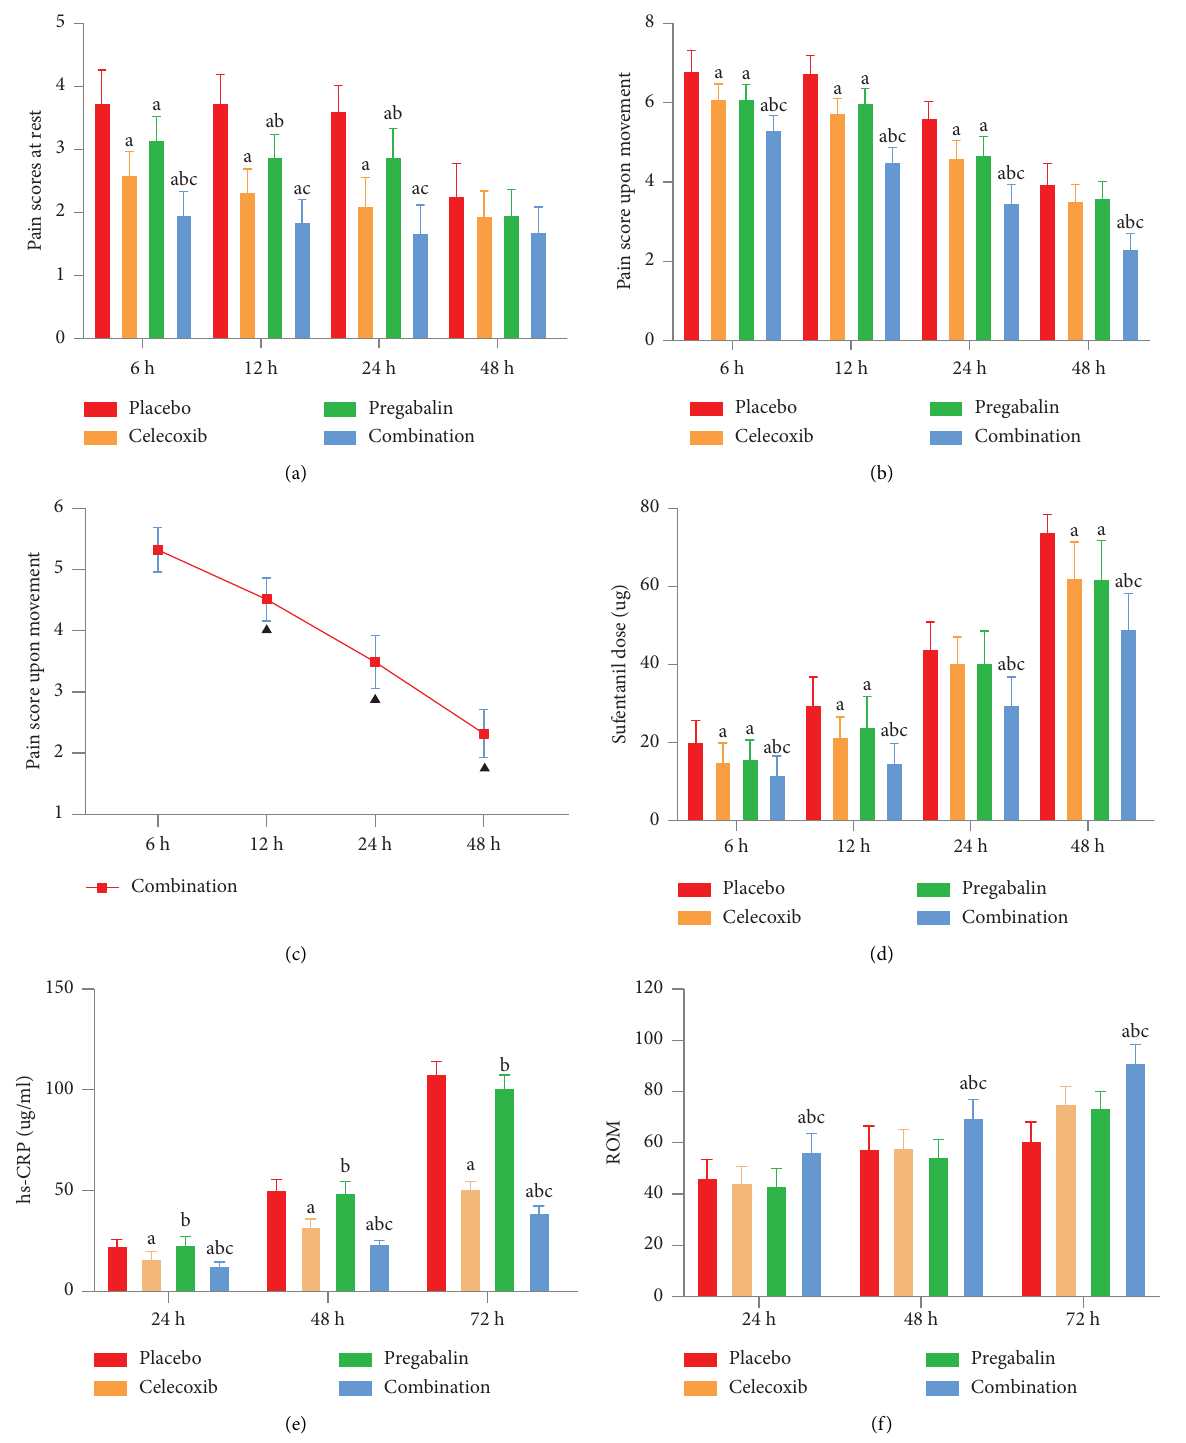
Figure 2: (a) Pain score at rest. (b) Pain score upon movement. (c) Pain score upon movement in the combination group. (d) Cumulative dose of sufentanil. (e) High-sensitivity C-reactive protein (hs-CRP). (f) Knee range of motion (ROM). ▲ indicates a signifcant diference compared with a previous time point in the combination group, which suggests that the pain scores upon movement in the combined group signifcantly decreased continuously over time. a indicates a signifcant diference compared with the placebo group ( P < 0 . 05); b indicates a signifcant diference compared with the celecoxib group ( P < 0 . 05); c indicates a signifcant diference compared with the pregabalin group ( P < 0 . 05). Te diference was signifcant at the ( P < 0 . 05)